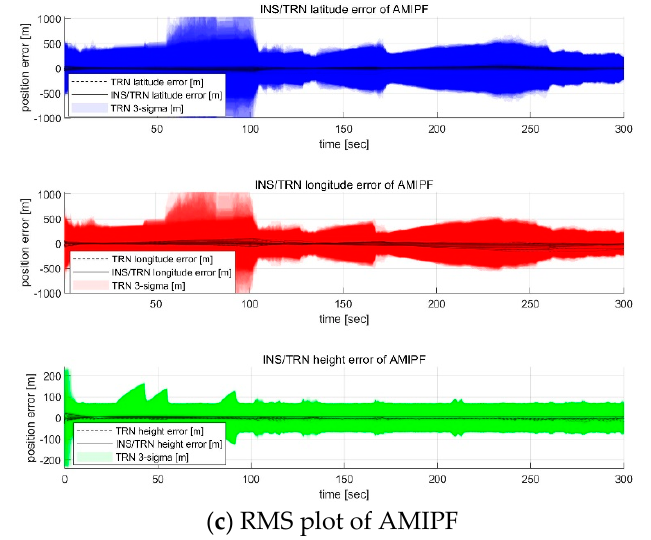
Figure 9. RMS plot of each filter on SIM2. ( a ) RMS plot of APF. ( b ) RMS plot of IAPF. ( c ) RMS plot of AMIPF. Table 3. Horizontal position error (CEP).